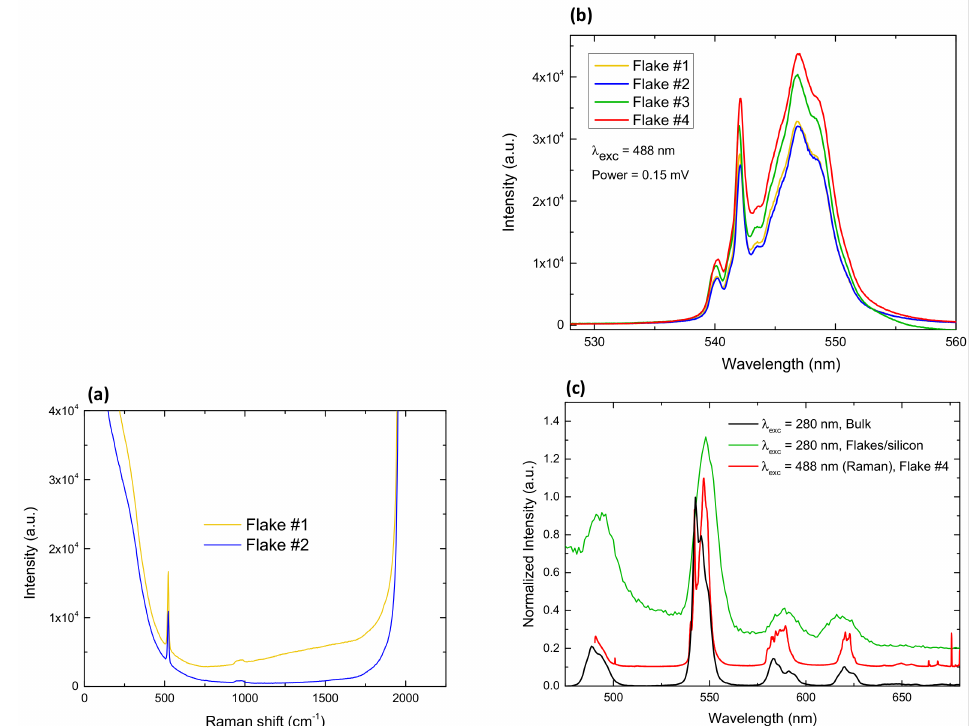
Figure 7. Raman spectroscopy of Tb-2D MOF flakes on silicon. ( a ) Raman shift spectra, relative to laser wavelength (488 nm) measured on two different flakes; ( b ) Tb emission spectrum peak measured on 4 different flakes, ( c ) Emission spectra obtained in Raman set up ( λ exc = 488 nm) from a single flake/silicon (red line) and of flakes on top of a Si waver upon ligand excitation, 280 nm (green line). Emission from bulk sample (black line). Spectra have been vertically shifted for the sake of